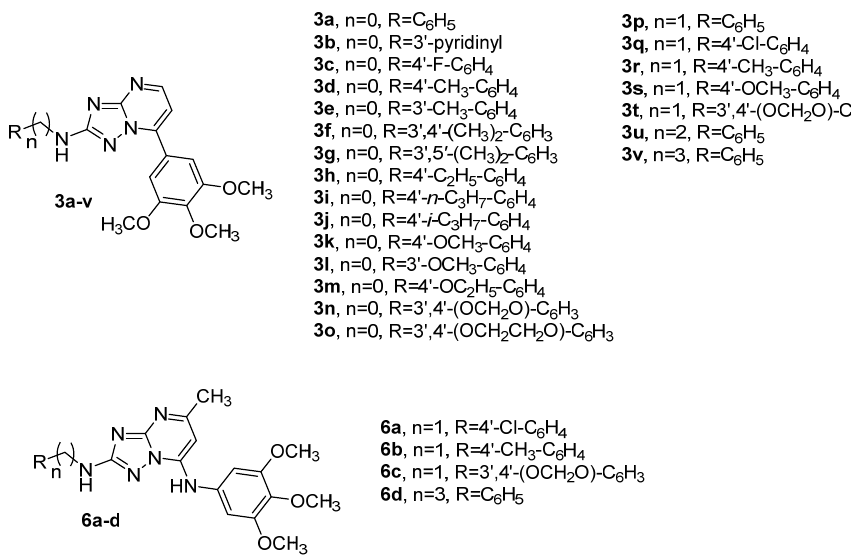
Figure 2. Chemical structures of newly synthesized compounds 3a–v based on the 7-(3 ′ ,4 ′ ,5 ′ -trimethoxyphenyl)[1,2,4]triazolo[1,5- a ]pyrimidine scaffold and general molecular formula 6a–d of triazolopyrimidines published by us (ref. [65]).